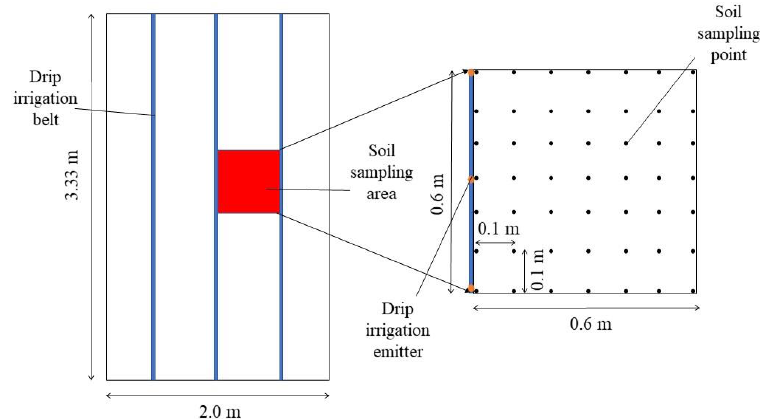
Figure 2. Schematic diagram of soil sampling points.